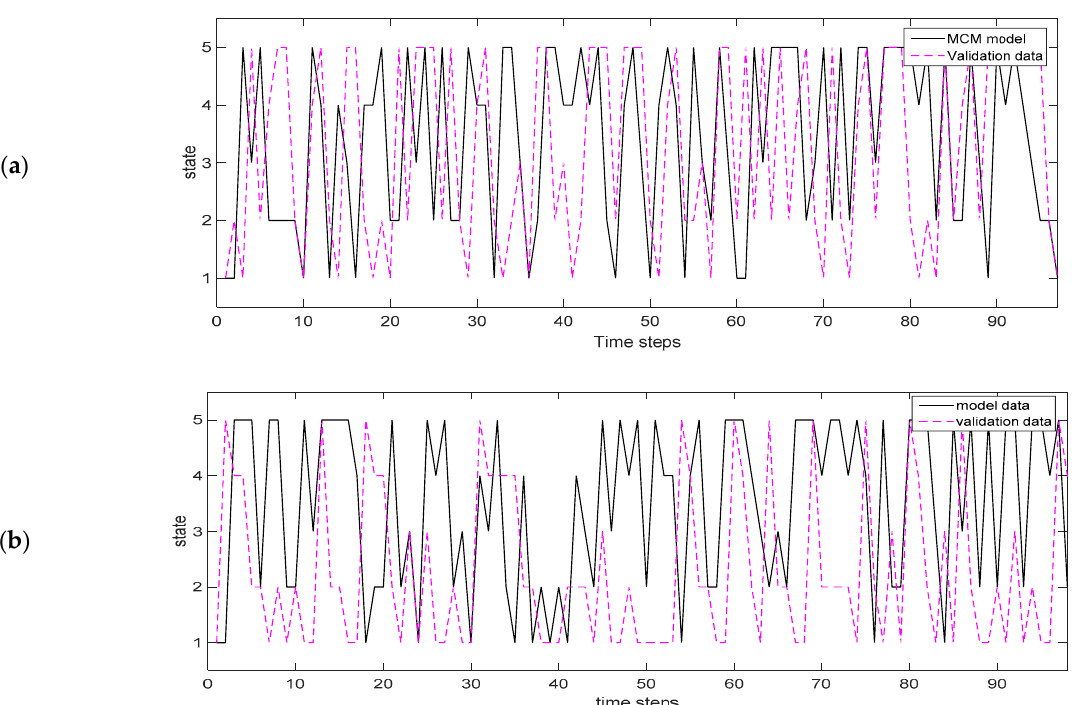
Figure 6. Medium term sequence of observations of the mosquito population process having five states generated from the trained model (black strait line) and that of the empirical intensity transition matrix. ( a ) Markov chain model and ( b ) conditional Markov chain model (pink dashed line) which were resembled using data that were not used for MC model training.